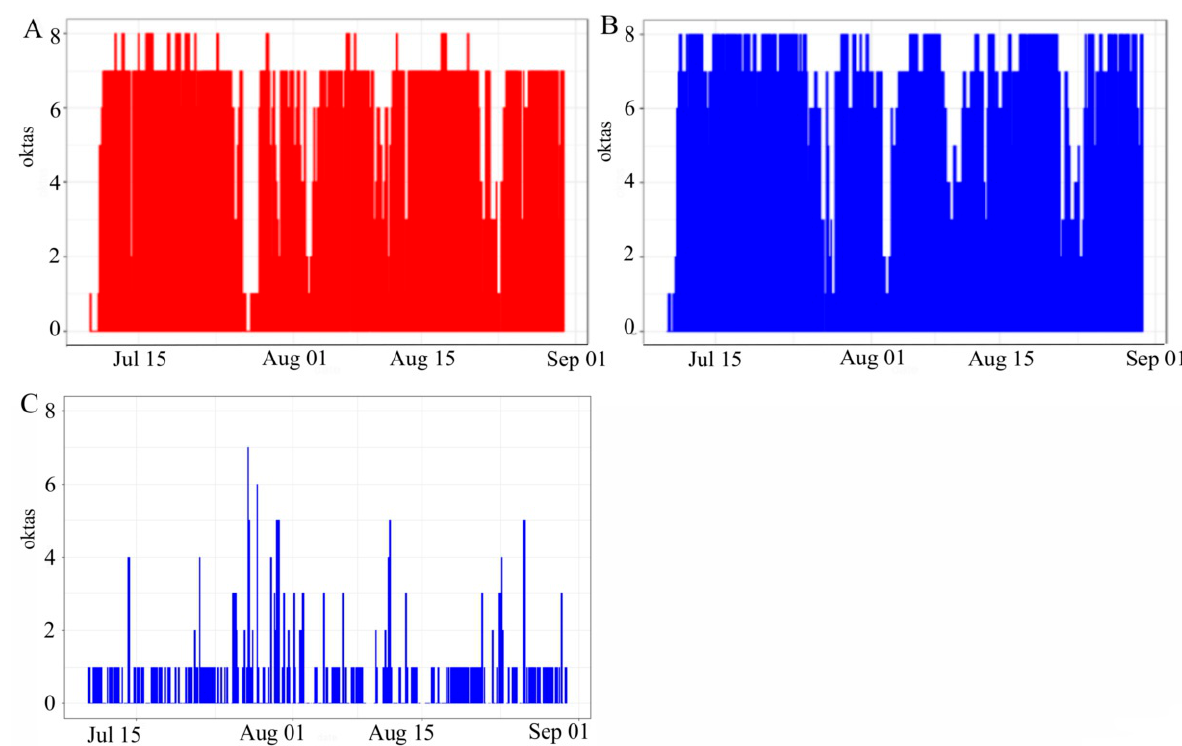
Figure 2. The frequency of cloudiness in Svalbard-Lufthavn ( A ) and Petuniabukta ( B ) during the period from 9 July to 30 August 2016.